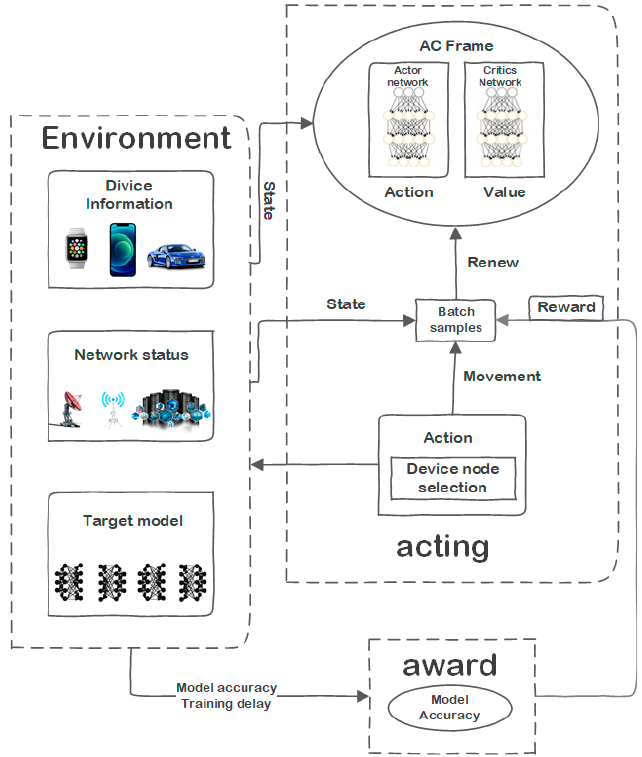
Figure 2. DRL-based node selection framework.